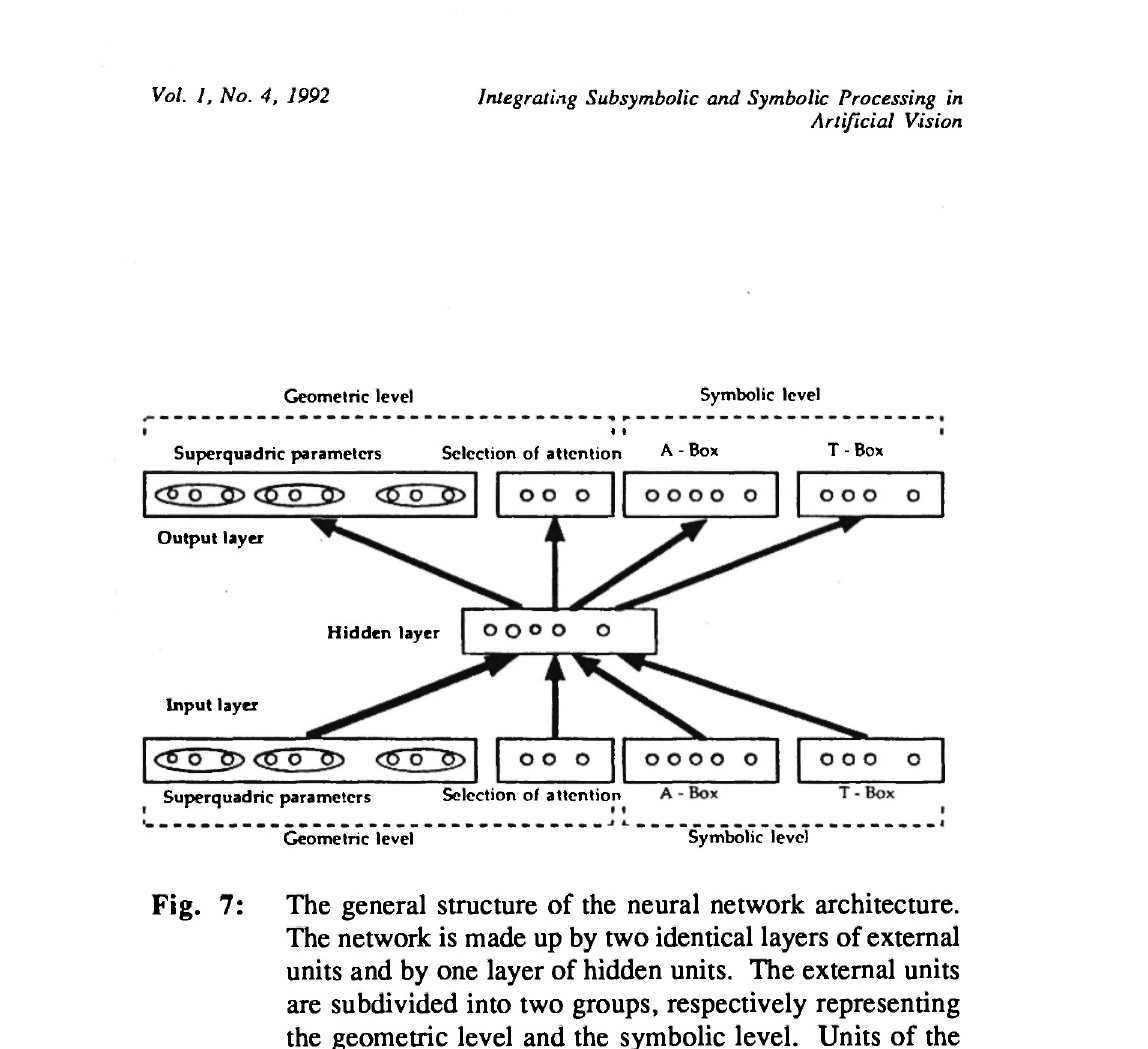
Fig. 7: The general structure of the neural network architecture. The network is made up by two identical layers of external units and by one layer of hidden units. The external units are subdivided into two groups, respectively representing the geometric level and the symbolic level. Units of the first group are in turn subdivided into two blocks. The first block is made up by clusters of units, each cluster repre- senting the geometric parameters of one superquadric. The second block is made up by units allowing the selection of attention: each unit of this block selects the attention on one superquadric. Also units of the second group are subdivi- ded into two blocks. Units of the first block are related to assertional constants (Α-Box), while units of the second block are related to generic concepts